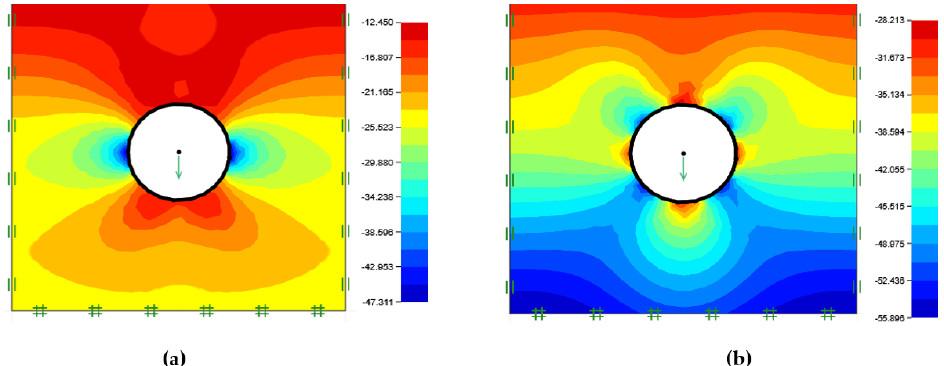
Figure 11. Principal stresses in soil. ( a ) horizontal plane and ( b ) vertical plane.